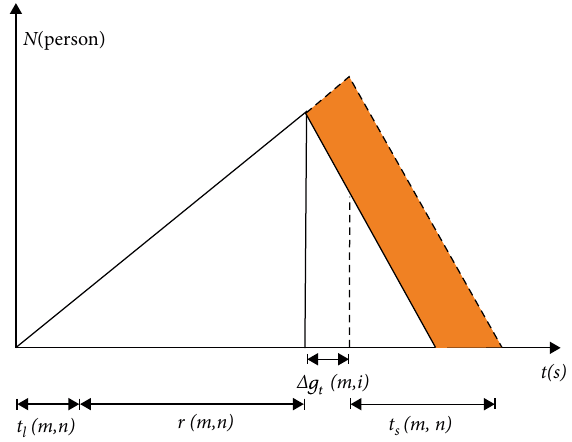
Figure 8: Analysis of partial priority vehicle delay at downstream intersection.